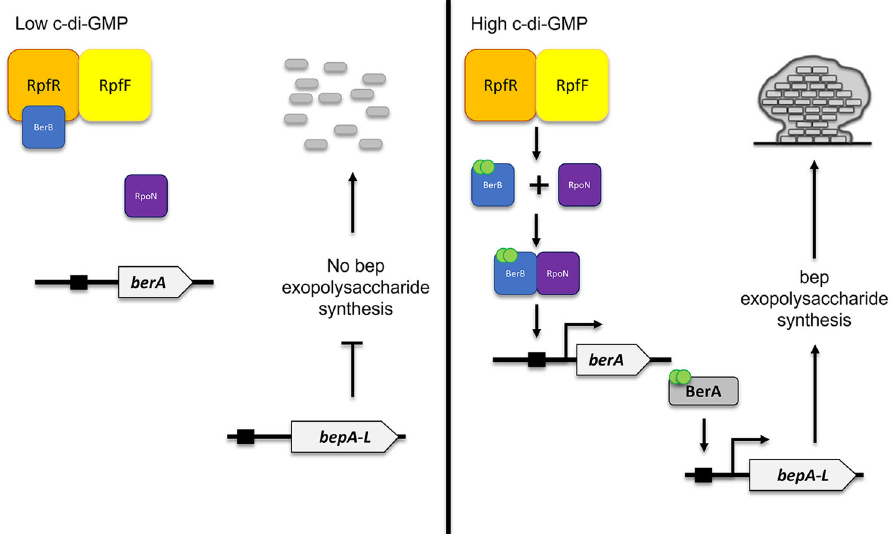
Fig. 9 Model of RpfR regulation of Bep exopolysaccharide synthesis. BerB binds to RpfR in complex with RpfF preventing its localization to the berA promoter. Rising levels of c-di-GMP lead to the binding of c-di-GMP to BerB, inhibiting the protein interaction and allowing the released BerB to stimulate transcription of berA , and the BerA protein then activates transcription of the bep operon. Modi fi ed from Fazli et al., 2017 16